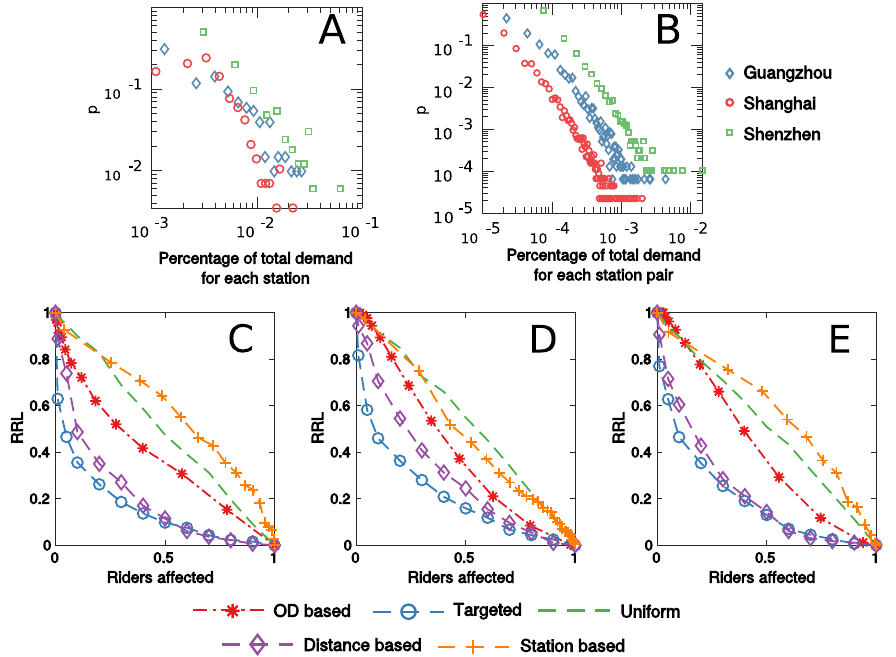
Figure 3. Distribution of travel demand and the effectiveness of different control strategies for the MCNs of the three cities. ( A ) presents the probability density function of the trip demand at the station level. ( B ) presents the probability density function of the trip demand of each pair of stations. ( C ), ( D ) and ( E ) visualize the effectiveness of OD based, targeted, uniform, distance based and station based control strategies for each city. The effectiveness of control strategies is compared with the proportion of trip demand affected by the corresponding